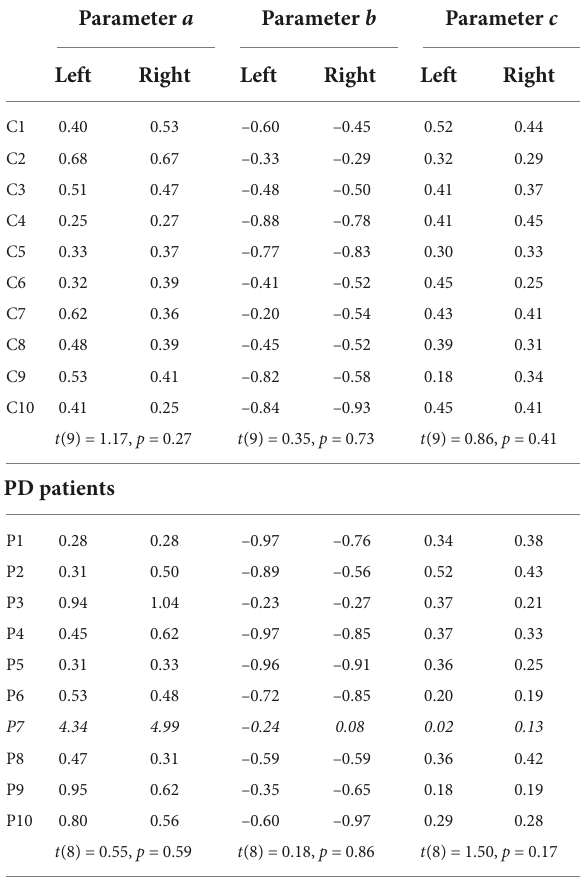
TABLE 2 Parameters for the sensory uncertainty model (equation 1), computed separately for the two starting positions of the ball. Healthy controls Parameter